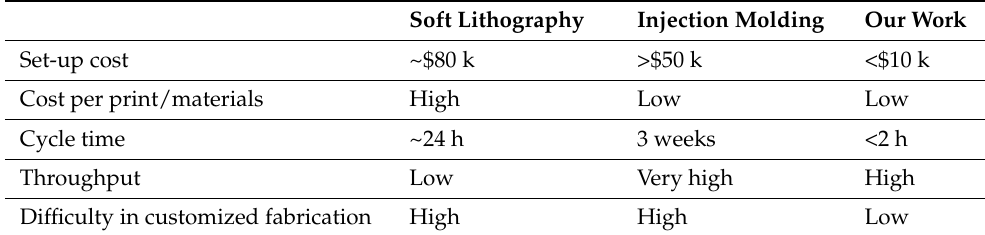
Table 1. Comparison of PbLT and conventional microfluidic chip fabrication methods. Soft Lithography Injection Molding Our